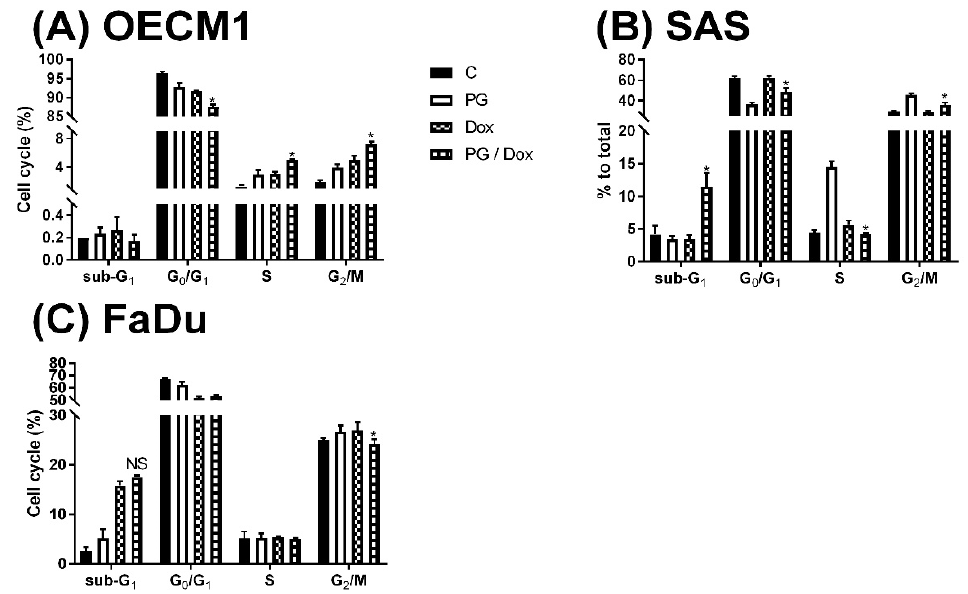
Figure 2. Alteration of cell cycle in ( A ) OECM1, ( B ) SAS, and ( C ) FaDu cells. OSCC cells were treated with PG/Dox for 12/12 h prior to staining with propidium iodide (PI) and fluorescent intensity was analyzed by flow cytometry. The results were represented as mean ± SD from three individual experiments. * p < 0.05 as compared with DOX alone.